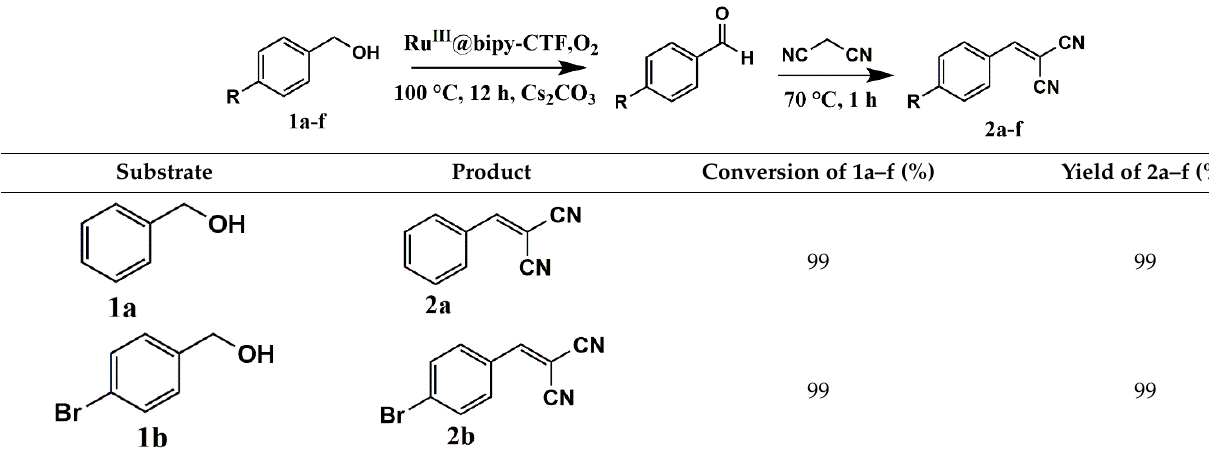
Table 3. Catalytic performance of Ru III @bipy-CTF catalyst in tandem aerobic oxidation–Knoevenagel condensation reaction.